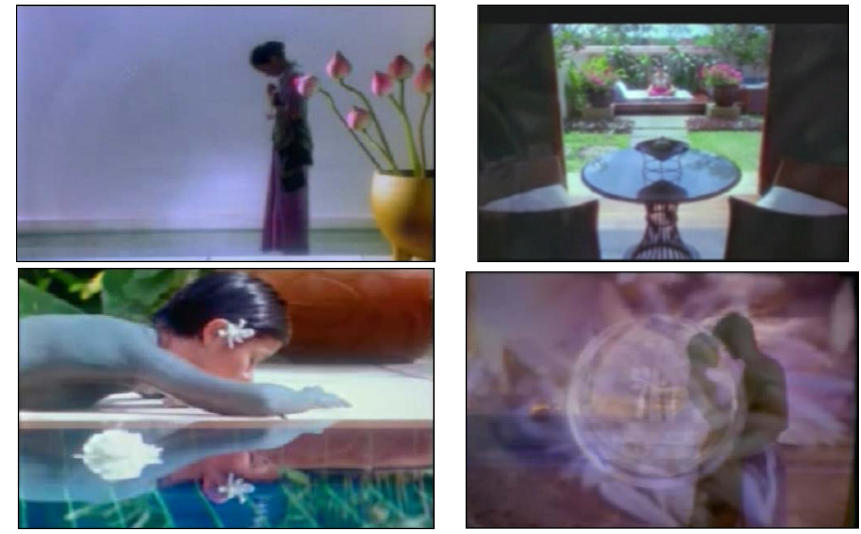
Figure 4. Screenshot TV commercial BT.